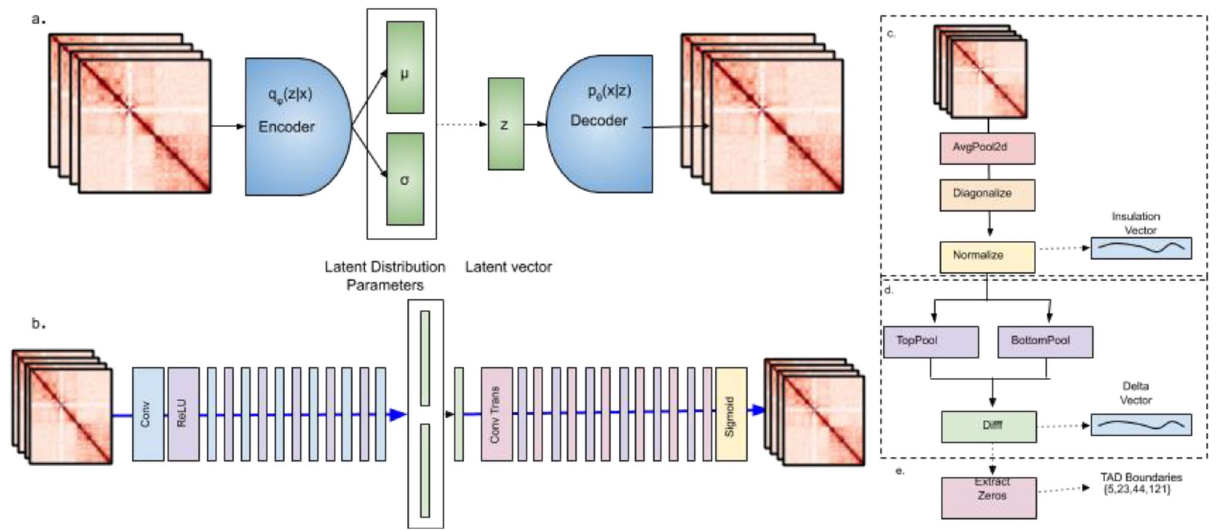
Figure 2. Variational autoencoder. ( a ) Overview of variational autoencoder approach. ( b ) VEHiCLE architecture. Tad loss evaluated using a feedforward implementation of Insulation loss computing, ( c ) insulation vector, ( d ) delta vector and ( e ) identification of TAD